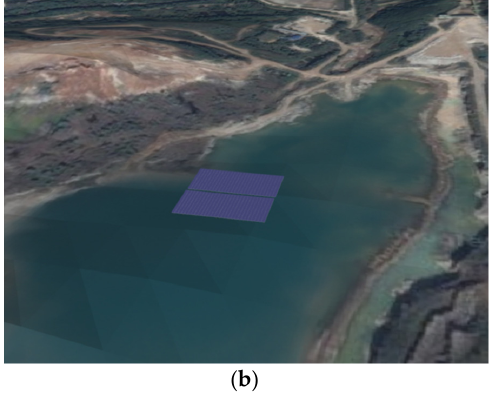
Figure 5. System design: ( a ) Schematic diagram of the photovoltaic system showing the connections among the PV modules, inverters, and charge controller; ( b ) aerial view of the system layout. Table 6 outlines the monthly and annual electricity production simulated after entering the meteorological data of the solar site, shading matrix (Table 3), and PV ‐ system design parameters (Table 4) into the SAM software. The highest monthly electricity output was in April at all tilt angles, and the lowest was in July due to meteorological characteristics of study site. The highest annual electricity production (971.57 MWh/year) resulted from a tilt angle of 40°. Based on this result, 40° was selected as the optimal tilt angle of the PV array, and the electricity production at the 40° tilt angle was used for the economic and GHG reduction analyses.